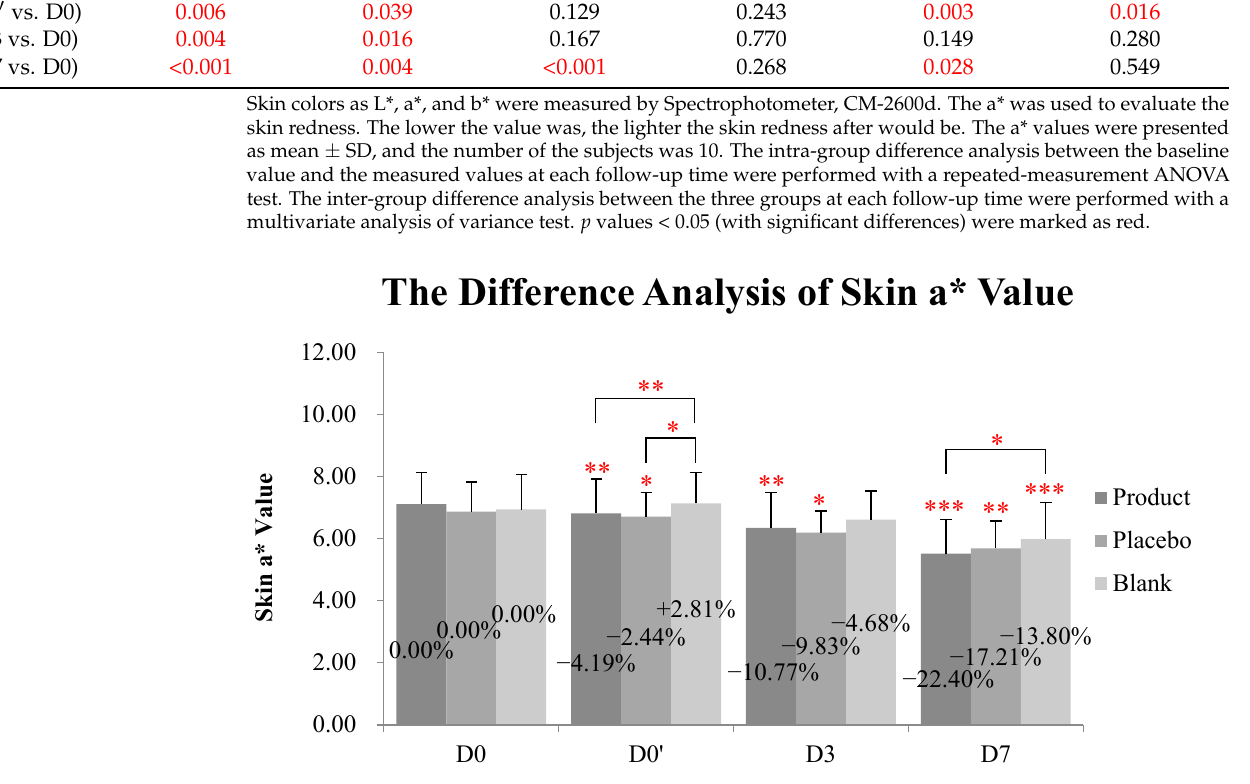
Figure 6. Reduction on skin a * value kinkéliba leaf extract was measured by Spectrophotometer, CM-2600d. The lower the value was, the lighter the skin redness after would be. Significantly differences between the baseline value and the measured values at each follow-up time in intra-group and inter-group: * p < 0.05, ** p < 0.01, *** p <0.001. D0: the day and time removing the patch; D0’: immediately after applying the test product; D3: three days after applying test product; D7: seven days after applying test product.